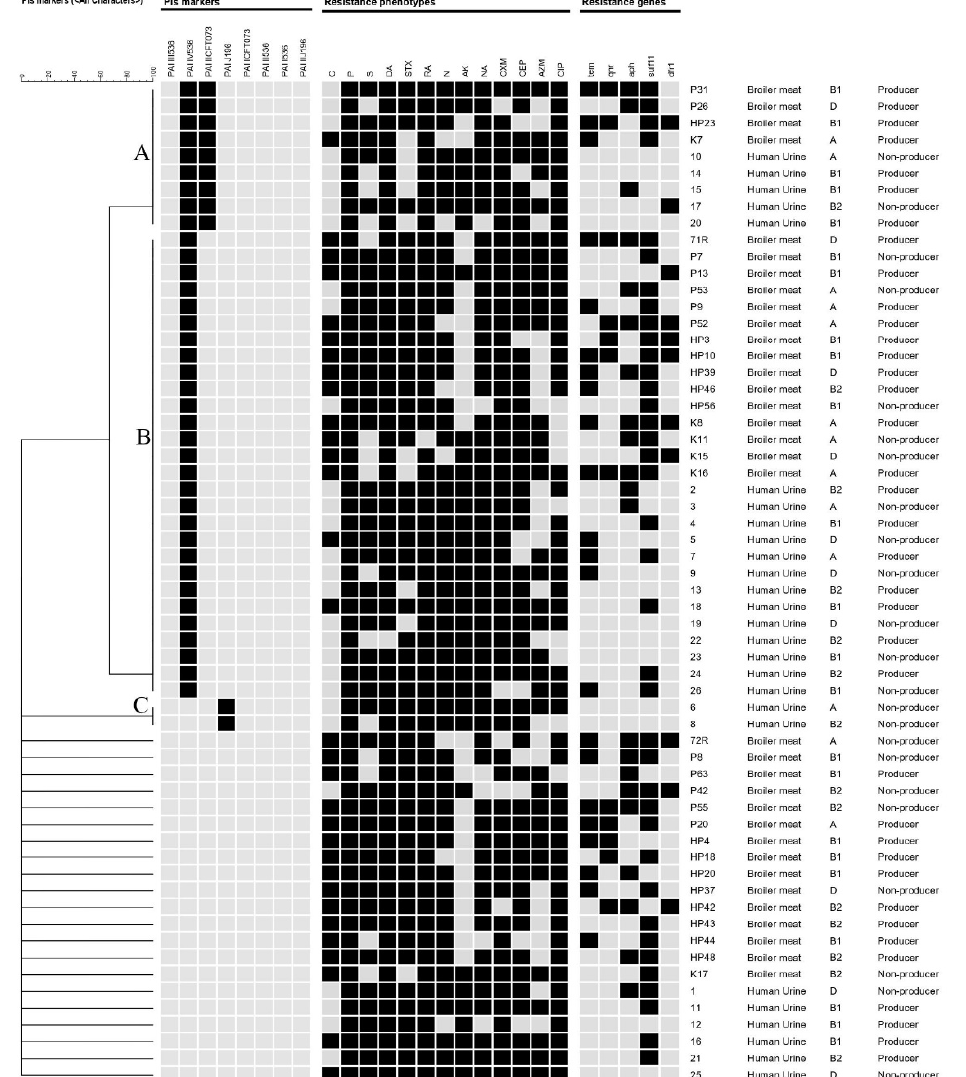
Figure 5. Hierarchal clustering of chicken and human isolates based on the existence of pathogenic islands (PAIs) using Dice coefficient and the unweighted pair group method (UPGMA) in BioNu- merics software (Applied Maths, Austin, TX, USA, version 7.6). Black and gray squares represent positive and negative results, respectively, for PAIs, resistant phenotypes, and resistant genotypes. Phylogroups and biofilm production results were also